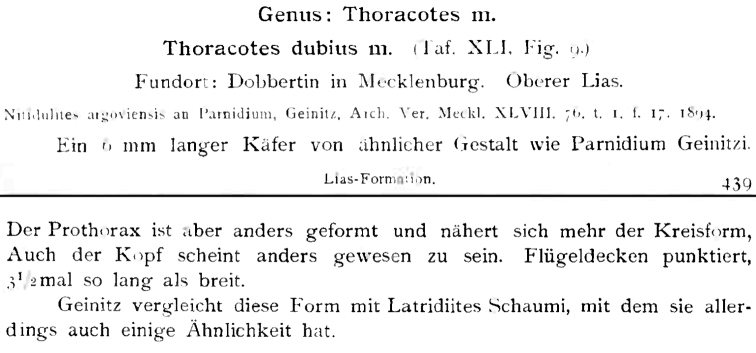
A facsimile of Handlirsch 1906: 438–439. The original description of Thoracotes dubius.